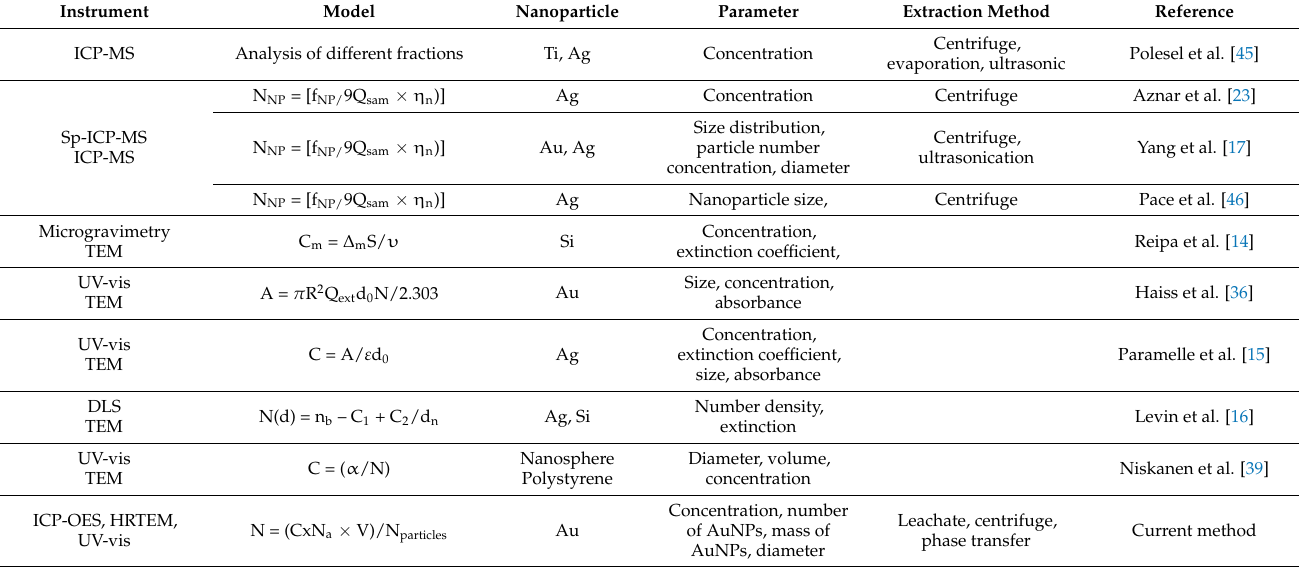
Table 3. Different methods from the literature to determine the concentration of